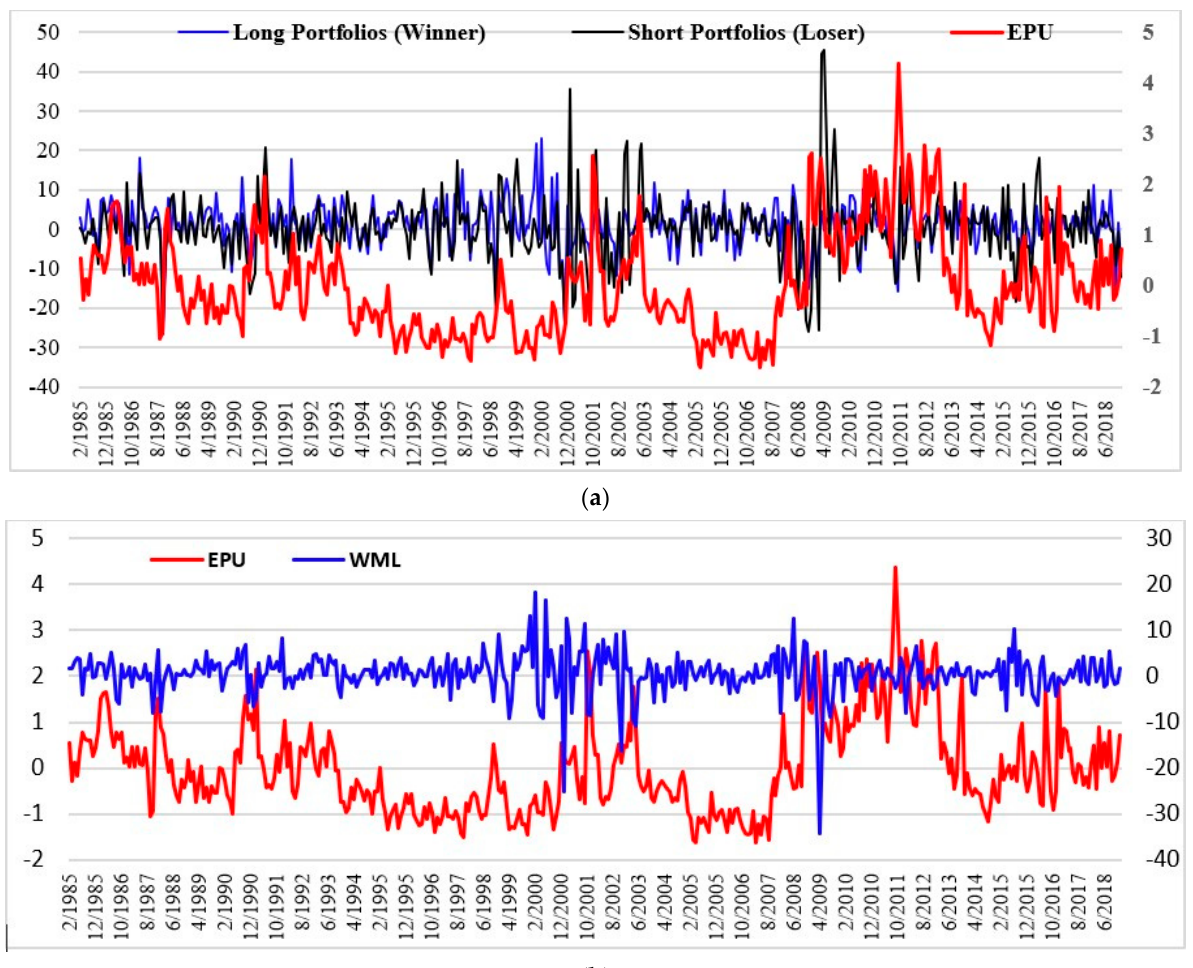
Figure 1. ( a ) Co ‐ movement between EPU and momentum portfolios. ( b ) Co ‐ movement between EPU and WML (hedge Figure 1. ( a ) Co-movement between EPU and momentum portfolios. ( b ) Co-movement between EPU and WML (hedge portfolio).